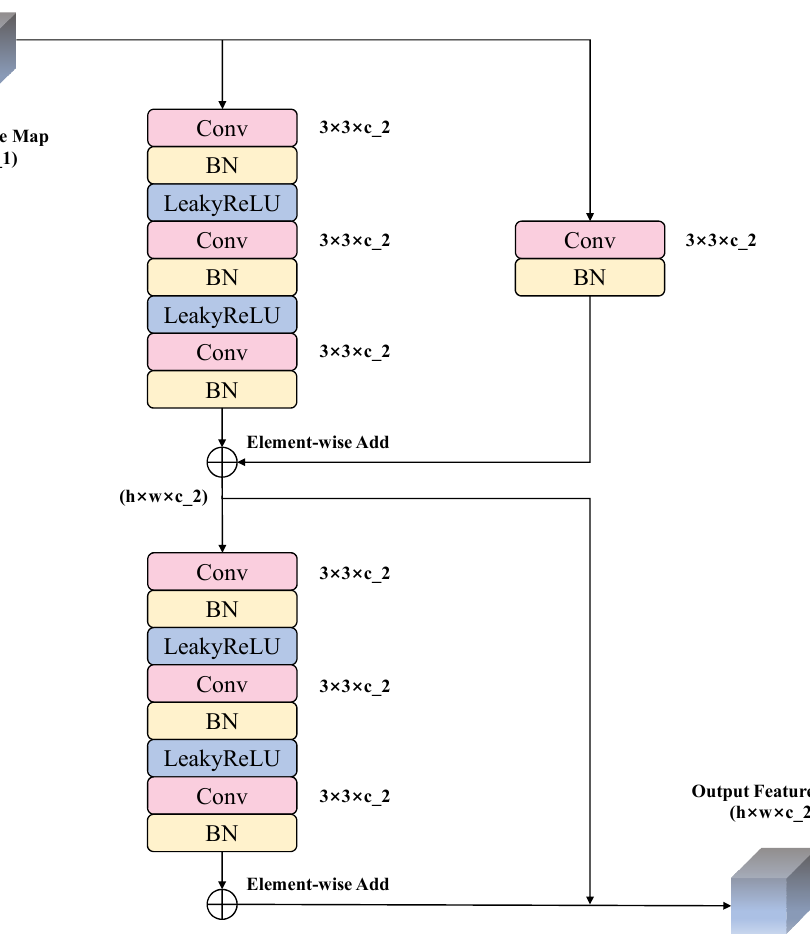
Figure 2. The architecture of the Residual Spatial-Spectral Module, where h , w and c represent the sizes of the feature maps and the kernel size of each convolutional layer is marked